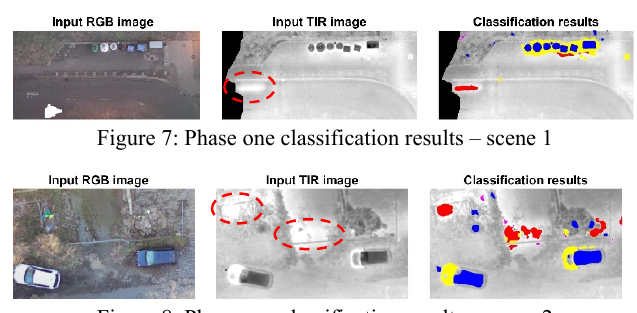
Figure 8: Phase one classification results – scene